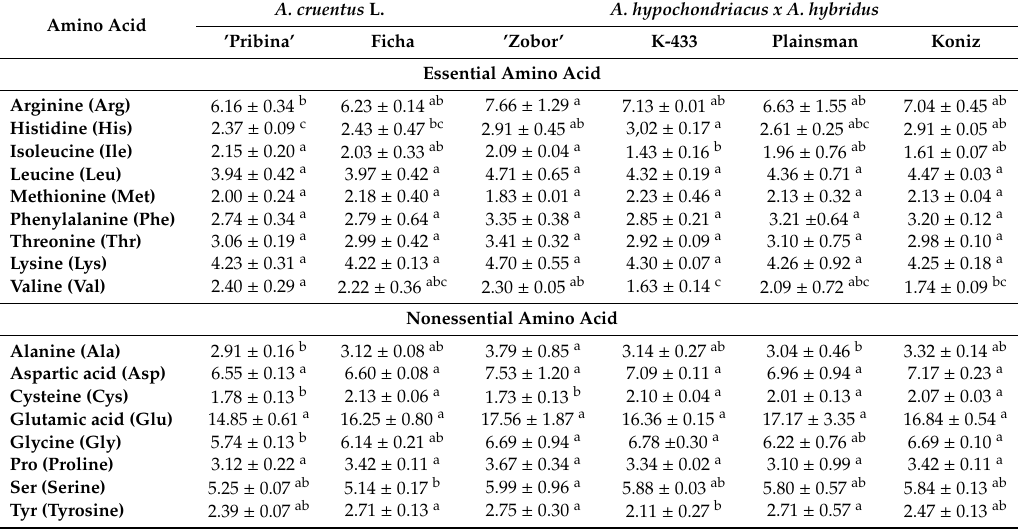
Table 2. Contents of essential and nonessential amino acids (g / 16 g N) in amaranth seeds in three year period